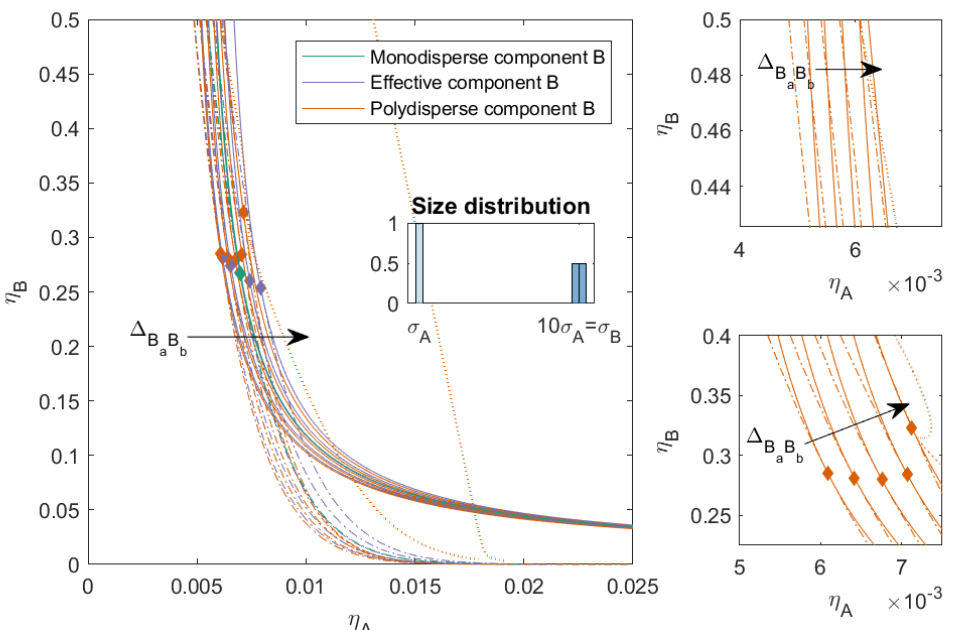
Figure 3. Phase diagram for binary (components A and B ) nonadditive hard sphere mixture with size ratio q = σ A / σ B = 1/10, plotted as a function of the partial packing fractions, η A and η B ; component A is monodisperse, component B is polydisperse ( PD = 4.00). The symbols σ A and σ B refer to the diameters of the species A and B, respectively. The interaction between components A and B is additive, the interaction between the subcomponents B is nonadditive, and the nonadditivity parameter ∆ B was varied from − 0.1 to 0.1 with a step size of 0.05 (the arrow indicates increasing a B b ∆ B a B b ). The spinodal (solid line) and binodal (dashed line) meet each other at the plait point (diamond), the three-phase boundary is indicated with a dotted line and meets the spinodal at the plait point (diamond). The two right-hand smaller figures represent zoomed-in sections of the main